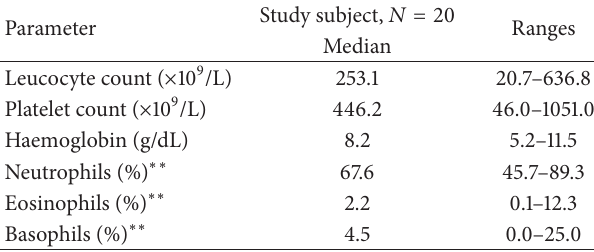
Table 1: Pretreatment full blood count profile of study